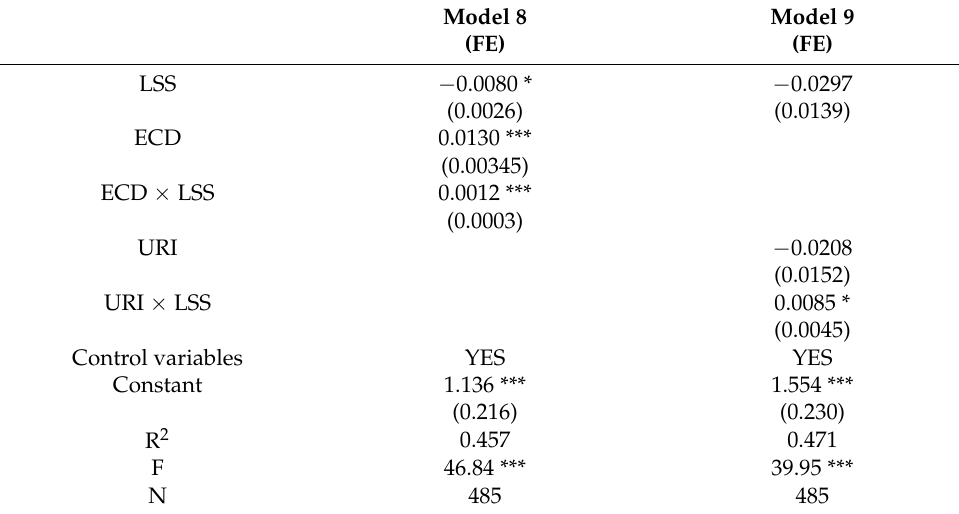
Table 5. Heterogeneity